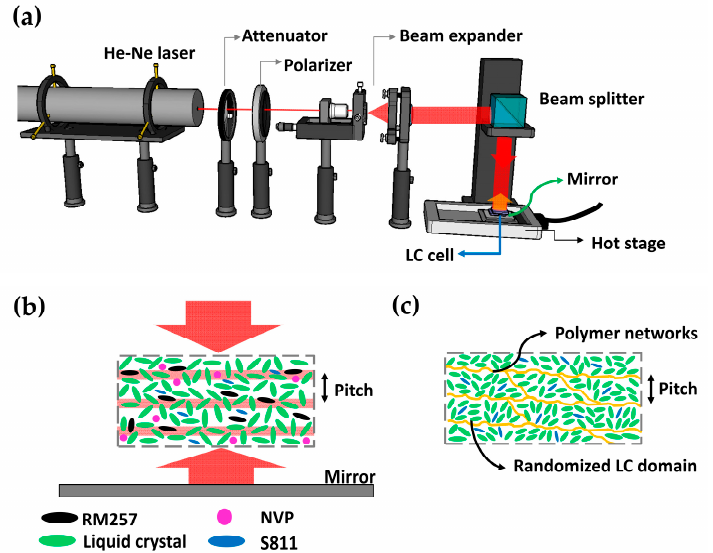
Figure 2. ( a ) Schematic setup and holographic exposure processes; ( b ) Schematic location of LC layer in the cell with holographic interference inside for the exposure process in the isotropic phase; ( c ) After exposure processes, there are small LC domains with random LC director distributions around the polymer networks.